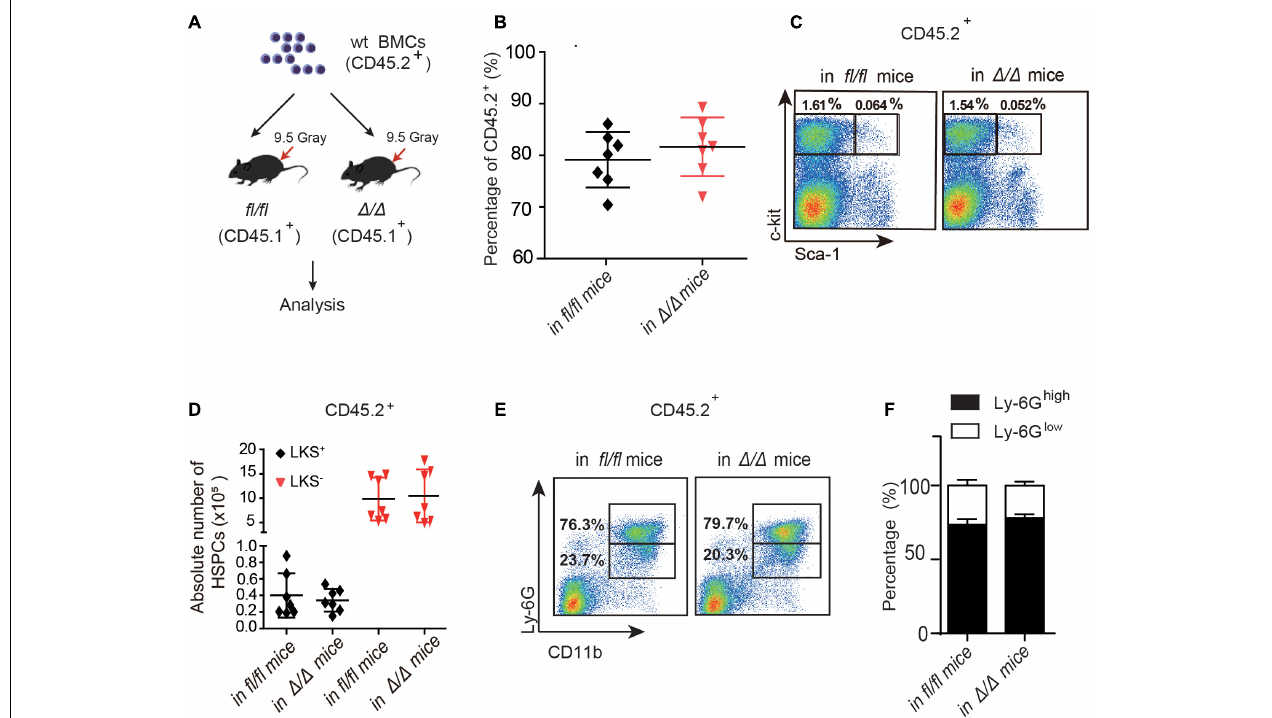
FIGURE 2 | The number of wt HSPCs showed no change in Rheb1 (cid:49)/(cid:49) and Rheb1 fl / fl mice at 4 months after transplantation. (A) Wild-type ( wt ) whole bone marrow cells (CD45.2 + ) were transplantation into lethally irradiated Rheb1 (cid:49)/(cid:49) or Rheb1 fl / fl mice. (B) The percentage of donor-derived cells (CD45.2 + ) in PB 4 months after transplantation. (C,D) The absolute number of donor-derived LKS + and LKS + cells (CD45.2 + ) in BM 4 months after transplantation. (E,F) The percentage of donor-derived CD11b + Ly-6G high / low cells (CD45.2 + ) in BM 4 months after transplantation. The data are presented as the mean ± SD, n =